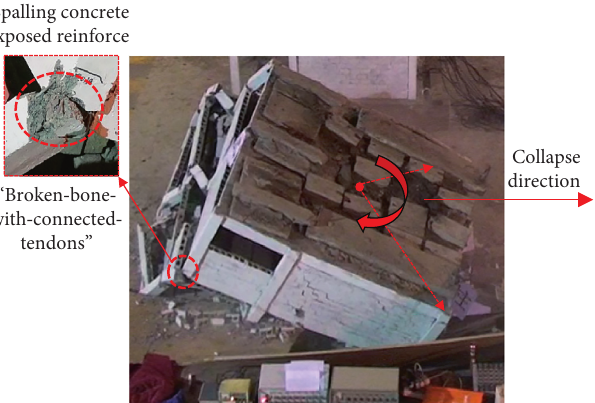
Figure 46: The collapse law of the shaking table test of RC frame